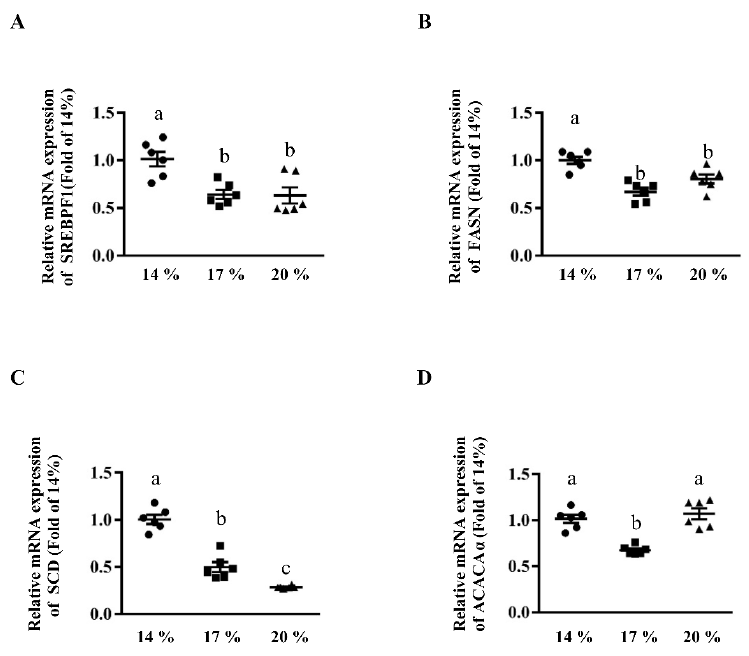
Figure A2. Effects of dietary crude protein level on hepatic lipogenesis genes expression. SREBPF1 ( A ), FASN ( B ), SCD ( C ), and ACAC α ( D ) mRNA abundance expression in liver of weaned piglets fed different dietary crude protein. Values are means ± SEMs, n = 6. Means without a common letter differ, p < 0.05. SREBPF1, sterol regulatory element binding transcription factor 1; FASN, fatty acid synthase; ACAC α , acetyl-CoA carboxylase alpha; SCD, stearoyl-CoA desaturase.